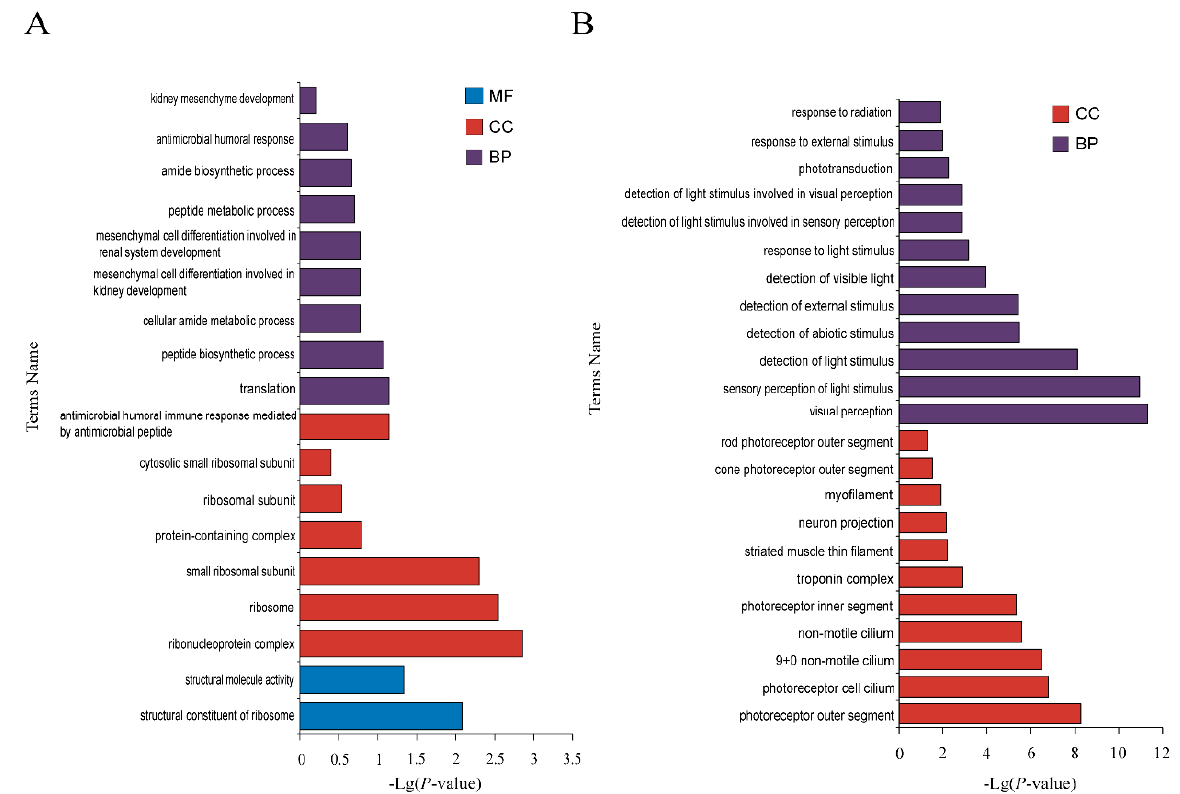
Figure 7. The functional enrichment analysis of specific genes expressed in the hypothalamus of Small Tail Han Sheep. ( A ) Enriched GO terms of luteal phase, ( B ) Enriched GO terms of estrus. Different bar chart colors represent different items. Purple represents BP, red represents CC, and blue indicated MF.